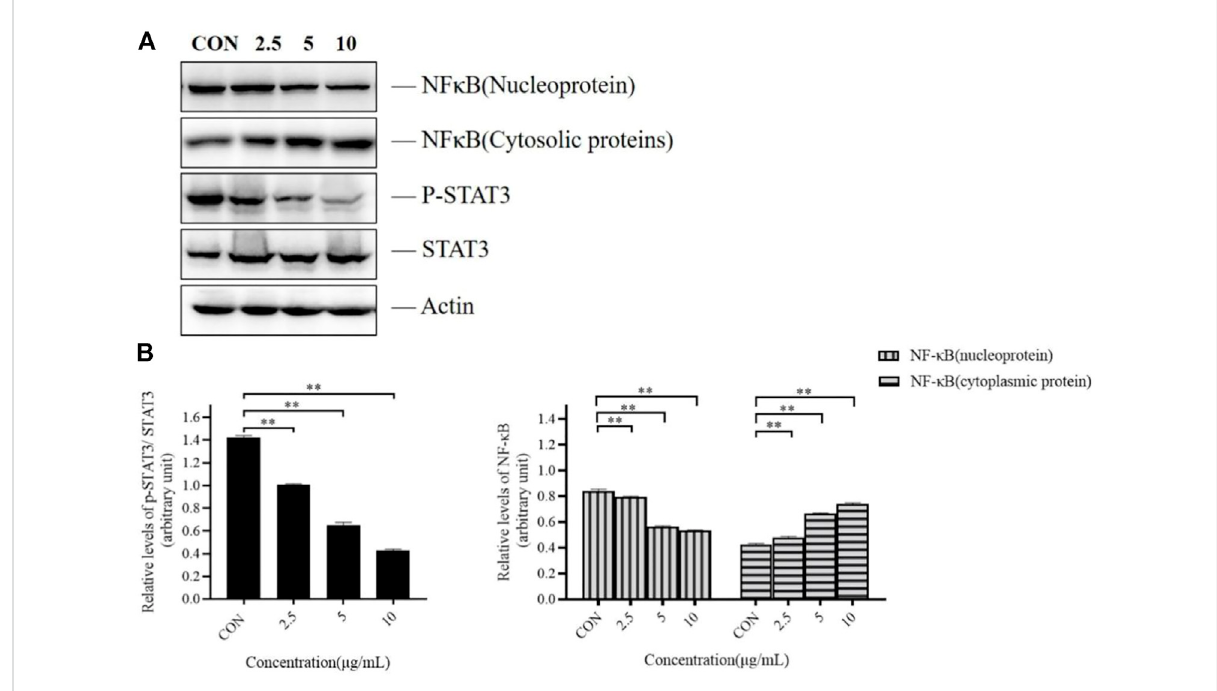
FIGURE 4 Effects of TTH on the NF- κ B and STAT3 pathway of H1975 cells. (A) Cell lysates were analyzed by immunoblotting and quanti fi ed. Representative immunoblots of STAT3 and NF- κ B were shown, with actin as the loading control. (B) Histogram summarized the results of (A) . Error bars represented means ± SD of n = 4. * p < 0.05 and ** p < 0.01 vs. control